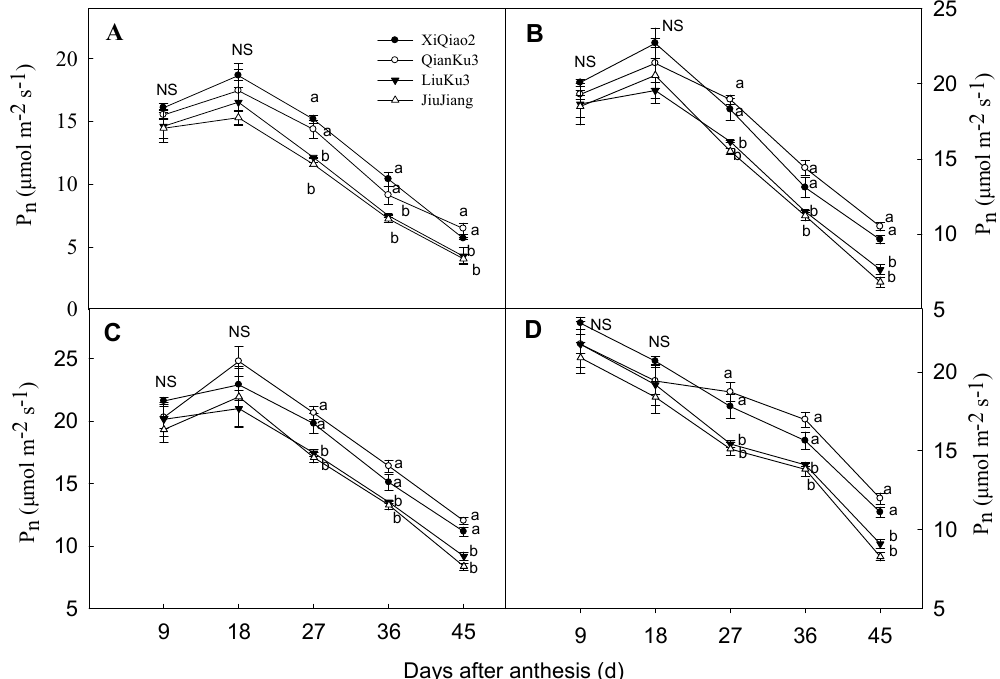
6 of 16 Figure 2. Soluble protein (SP) content in the leaves of four Tartary buckwheat cultivars at different flowering nodes. Panels ( A )–( D ) show results for the leaves of the 6th, 7th, 8th, and 9th flowering